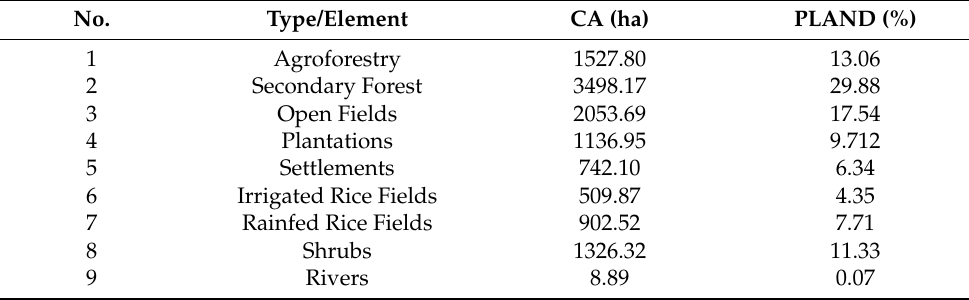
Table 6. Calculation results of CA and PLAND metrics at the class